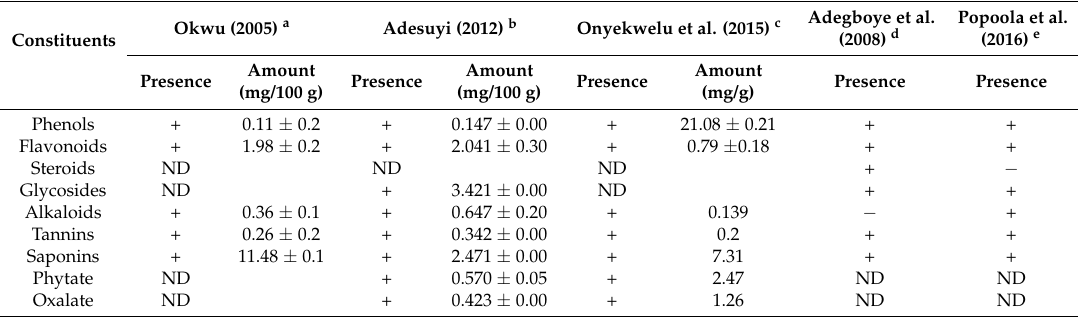
Table 4. Phytochemical composition of G. kola seeds on a dry weight basis reported by various authors. Adegboye et al. Popoola et al. Okwu (2005) a Adesuyi (2012) b Onyekwelu et al. (2015) c (2008) d (2016) e Constituents Amount Amount Amount Presence Presence Presence Presence Presence (mg/g) (mg/100 g) (mg/100 g) Phenols